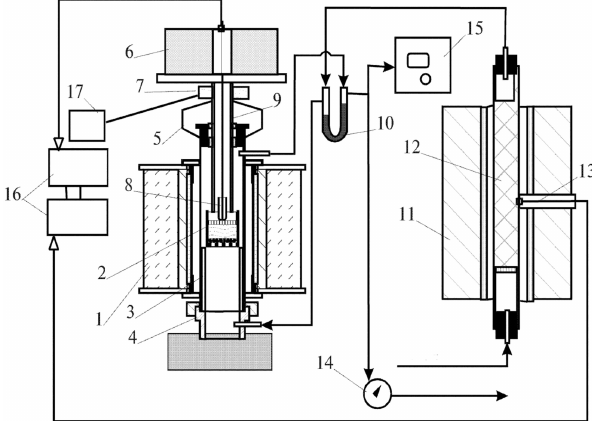
Figure 1. Laboratory installation scheme: 1 – Tamman fur- nace; 2 – graphite crucible; 3 – alumina reactor; 4 – hy- droseal; 5 – rubber chamber; 6 – load; 7 – slide-wire gage; 8 – Pt/Pt-Rh thermocouple in alumina jacket; 9 – alumina pipe; 10 – manometer; 11 – resistance furnace; 12 – coke breeze; 13 – thermocouple; 14 – flow meter; 15 – chro- matograph; 16 – temperature controller; 17 – shrinkage